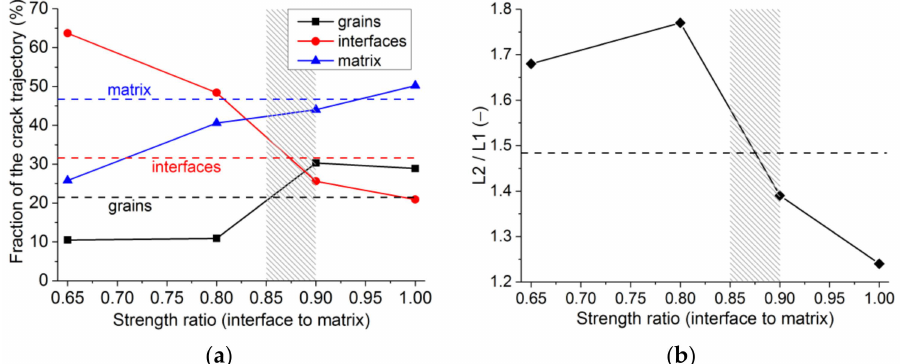
Figure 7. Comparison of the virtual and real crack trajectories for crack portions through different constituents of the model samples ( a ) and the crack non-linearity parameter L2/L1 ( b ). Horizontal dashed lines denote experimental values for silica refractory [12]. The rectangular shaded area marks the interval where the model is considered to agree with the